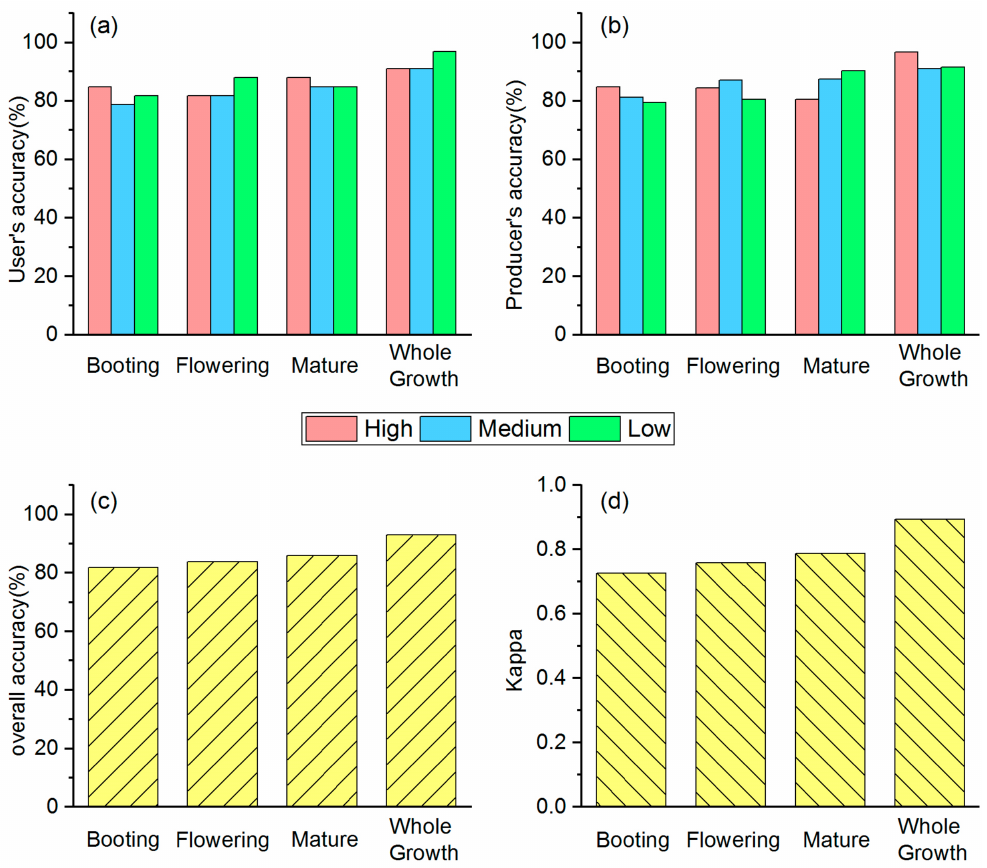
Figure 3. Classification accuracies of multitemporal monitoring model for discriminating different stress levels at different growth stages. ( a ) User’s accuracy of multitemporal monitoring model; ( b ) producer’s accuracy of multitemporal monitoring model; ( c ) overall accuracy of multitemporal monitoring model; ( d ) kappa coefficient of multitemporal monitoring model.